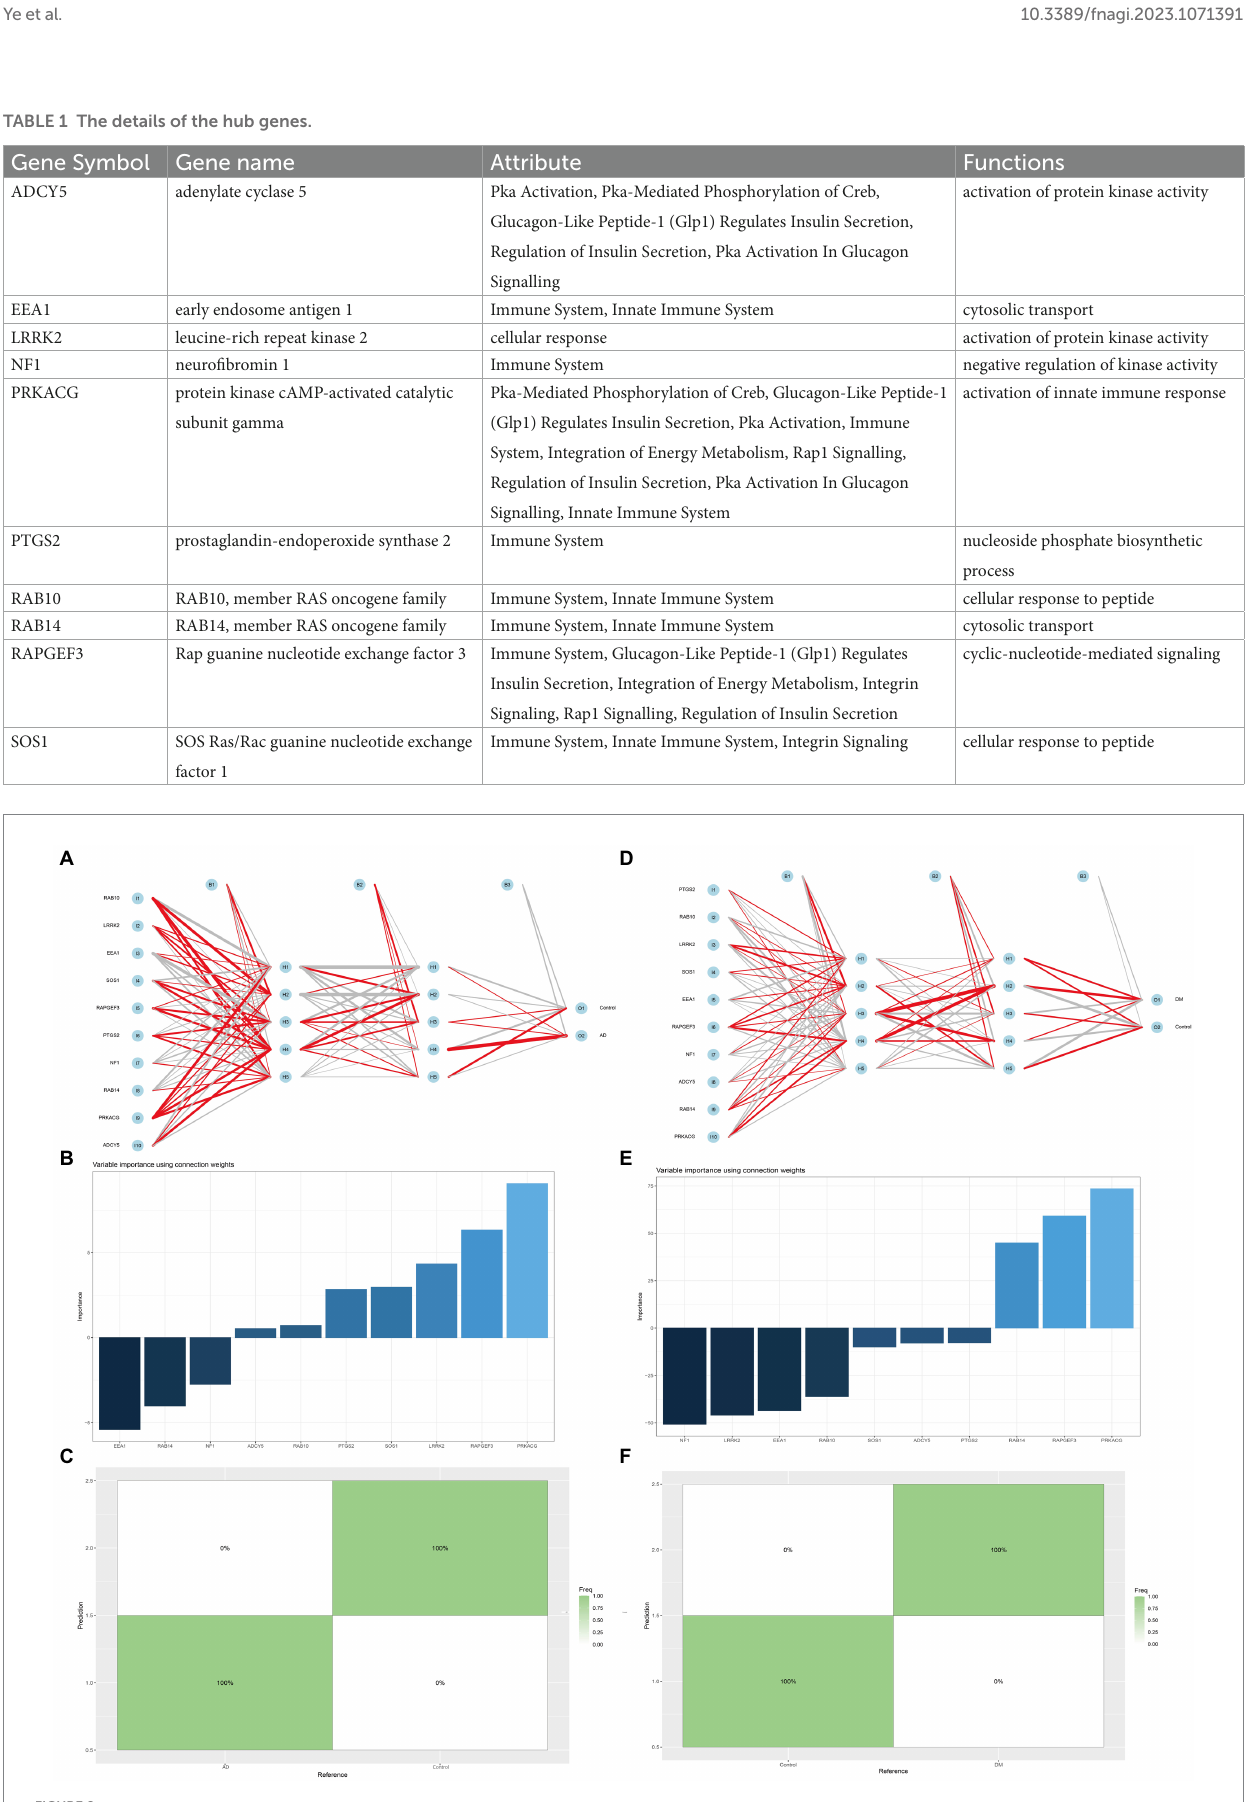
FIGURE 8 Multilayer perceptron networks analysis. (A,D) Neural network analysis of Hub gene in AD and DM groups, (B,E) The importance of each independent variable to the AD or DM model prediction, and (C,F) The prediction effect of the MLP classifier on the dataset of AD or